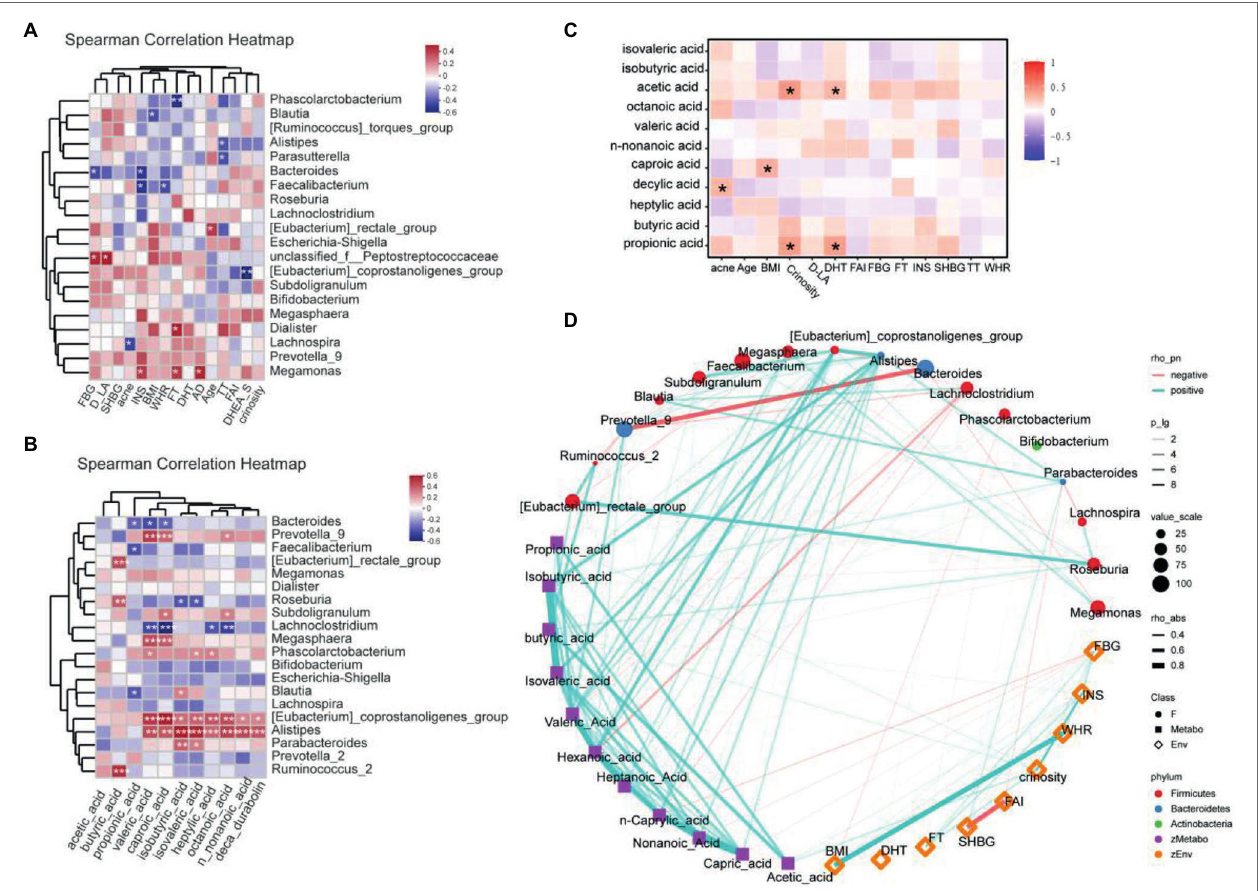
FIGURE 6 | (A) Heatmap of correlation analysis between gut microflora and clinical indexes of PCOS. (B) Heatmap of correlation analysis between gut flora and SCFAs. (C) Heatmap of correlation analysis between fatty acids and clinical indexes. (D) Network diagram among clinical indicators, intestinal flora, and SCFAs. SHBG, Sex hormone binding globulin; FT, Free testosterone; DHT, Double hydrogen testosterone; FBG, Fasting blood glucose; D-LA, D-lactic acid; AD, androstenedione; DHEA-S, dehydroepiandrosterone-sulfate; INS, Insulin; BMI, Body mass index; WHR, Waist hip rate; FAI, Free androgen index; SCFAs, short- chain fatty acids. * p ≤ 0.05; ** p ≤ 0.01; and *** p ≤